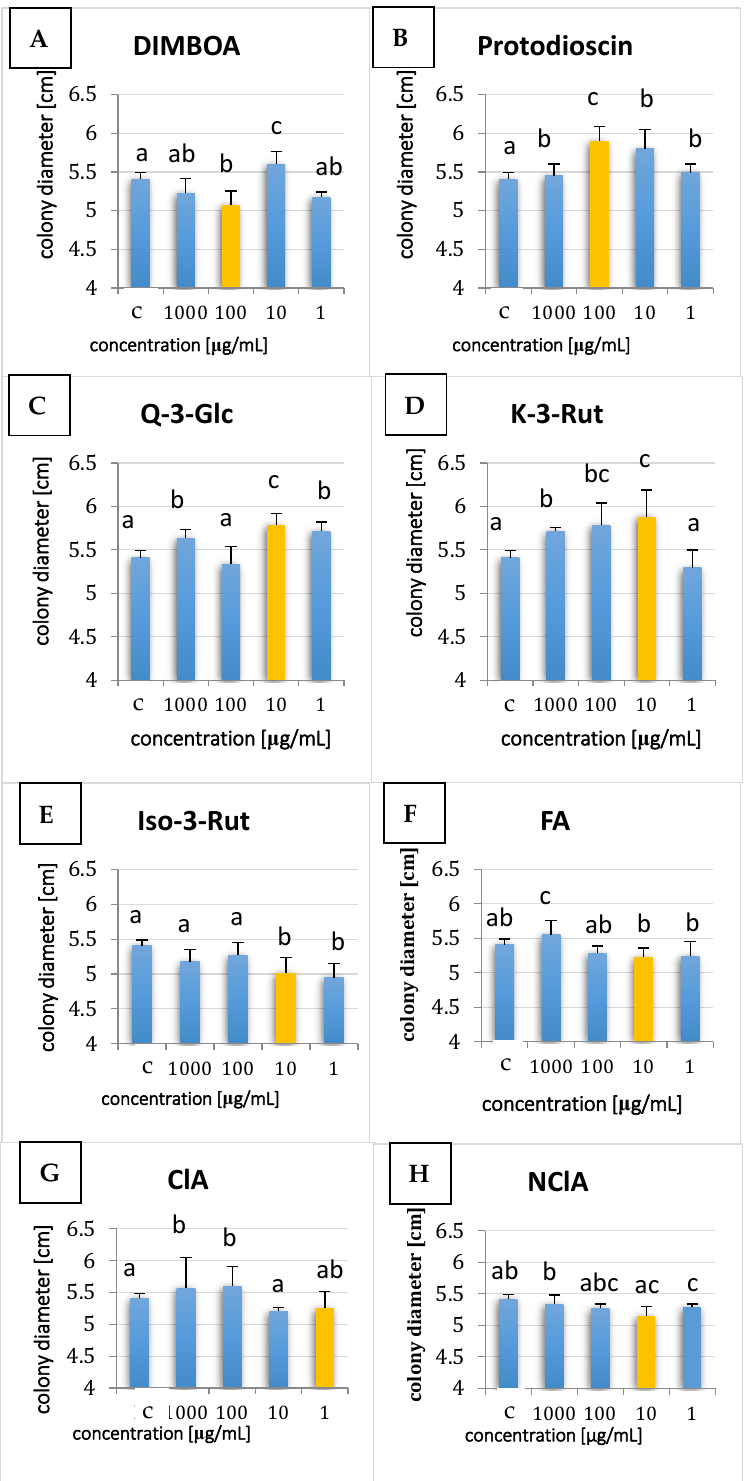
Figure 2. Colony diameters of the F. proliferatum KF 3360 strain under three concentrations of eight plant metabolites (details in Table 1) after six days of cultivation. Panels ( A – H ) show results for individual metabolites studied. C stands for controls, values are means of three repetitions ± standard deviation (HSD Tukey test, p < 0.05). Yellow bars represent the concentration used for liquid cultures and gene expression analyses.